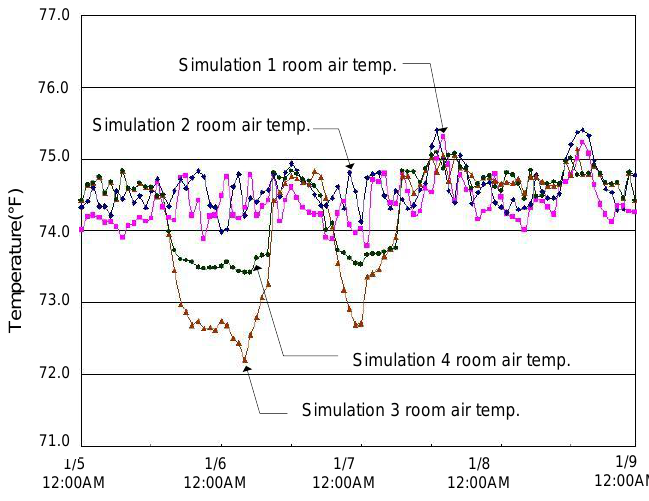
Figure 3. Simulation results of south zone air temperature.